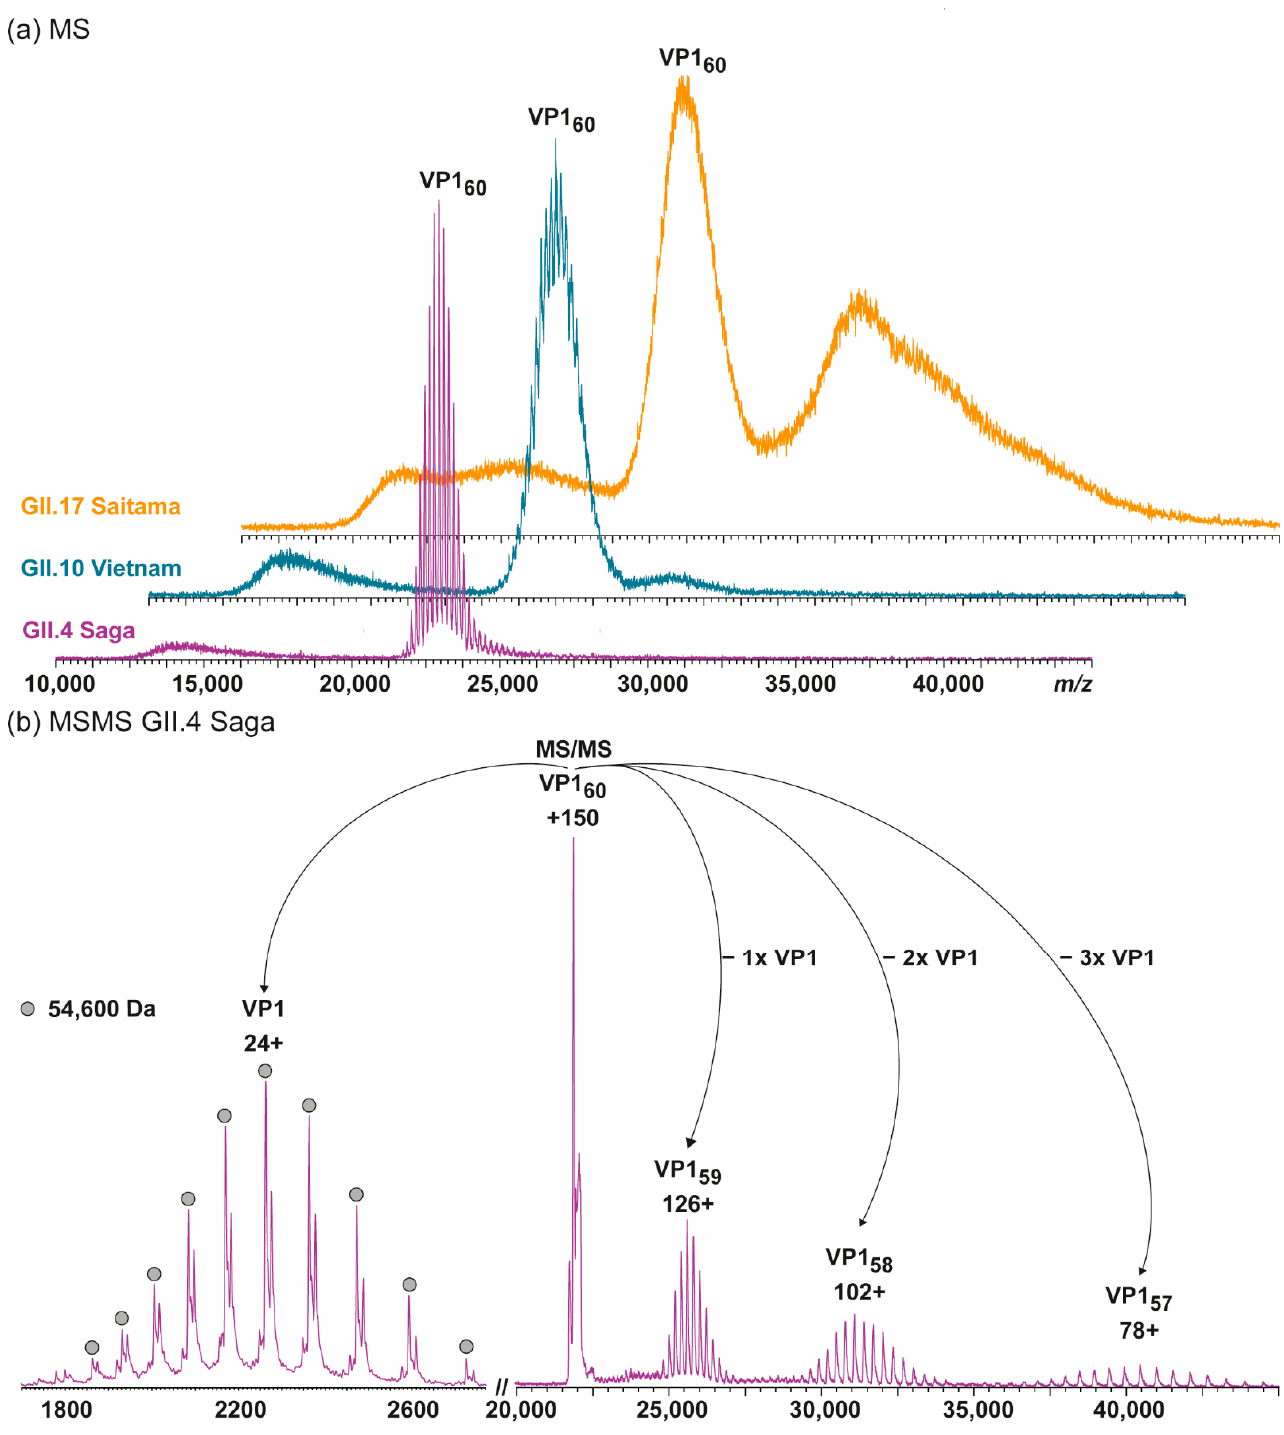
Figure 1. Native MS of different human norovirus-like particles (hNoVLPs) suggests that a major truncation of VP1 leads to T = 1 particles. ( a ) From bottom to top spectra of GII.4 Saga (purple), GII.10 Vietnam (blue), and GII.17 Saitama (orange) in 250 mM ammonium acetate pH 7 at 10 µM VP1 are shown. All variants have main ion distributions between 20,000 and 25,000 m/z , which are assigned to VP1 60 complexes. GII.10 Vietnam and especially GII.17 Saitama also form larger assemblies as indicated by additional signal above 25,000 m / z. ( b ) Collision-induced dissociation MS/MS is shown exemplarily for GII.4 Saga. The dissociation of the 150+ charged VP1 60-mer into VP1-monomer (top left) and residual VP1 59-, 58-, and 57-mer (top right) is shown. Charge states and average monomer mass are annotated. The MS/MS confirms stoichiometry assignment and reveals monomer truncation.